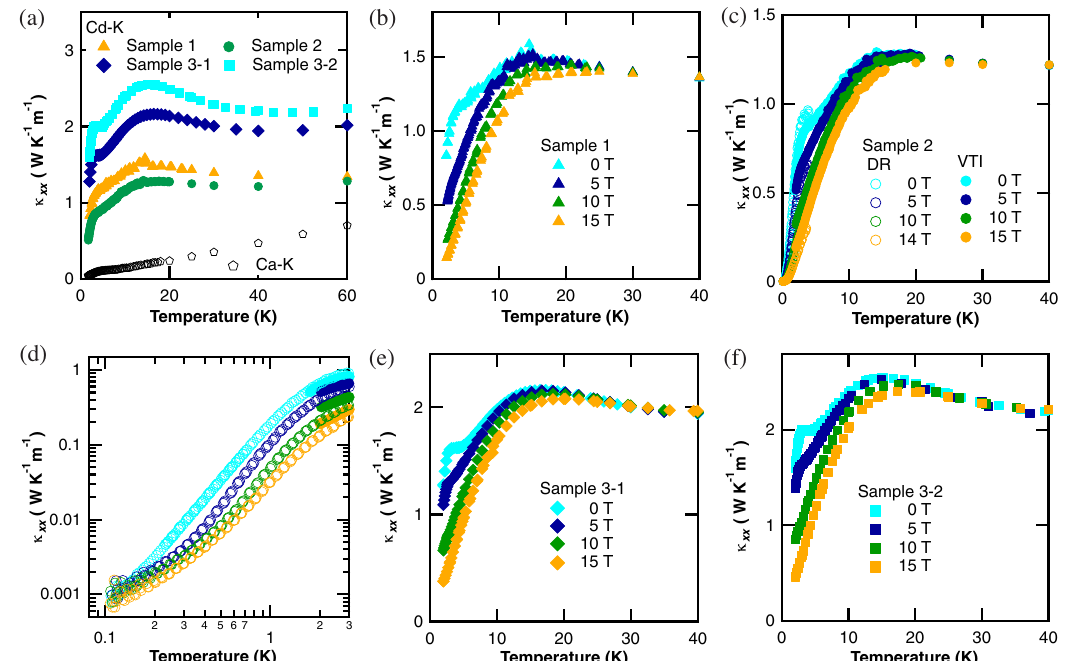
FIG. 2. (a) Temperature dependence of the longitudinal thermal conductivity ( κ ) of all samples of Cd-kapellasite (Cd-K) and that of xx Ca-kapellasite (Ca-K) at 0 T. The longitudinal thermal conductivity of Ca-K is taken from Ref. [26]. (b) – (f) The data of each sample under magnetic fields. In sample 2, κ is measured down to 0.1 K. An enlarged view of the low-temperature region (0.1 – 3 K) of (c) is xx shown in (d). The filled and open circles in (c) and (d) show κ measured by a VTI ( 2 K < T ) and a DR ( 0 . 1 < T < 4 K), respectively. xx The slight difference between the two data might be caused by a thermal cycle effect and/or different setups between the VTI and the DR measurements.